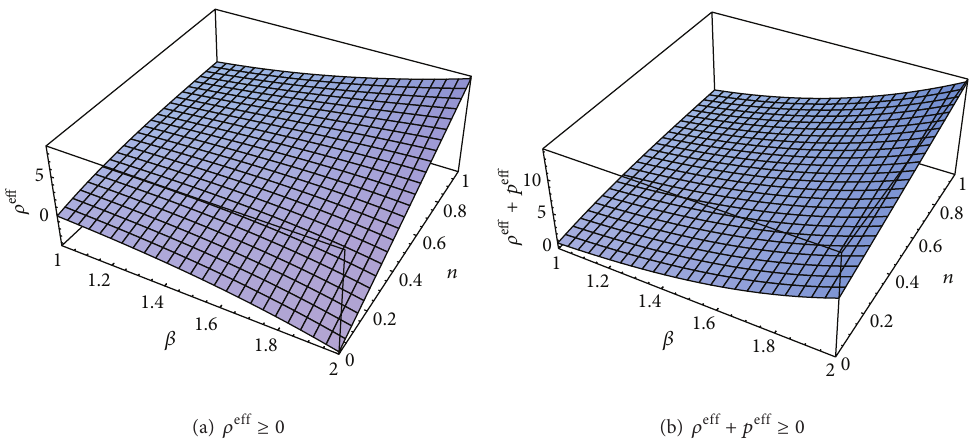
Figure 4: Plots (a) and (b) show WEC, namely, 𝜌 eff ≥ 0 and 𝜌 eff + 𝑝 eff ≥ 0 versus parameters 𝑛 and 𝛽